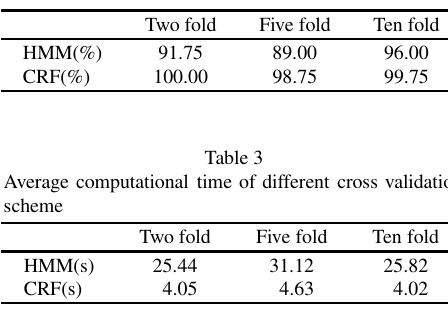
Fig. 6. Comparison of CRF with HMM under two-fold cross